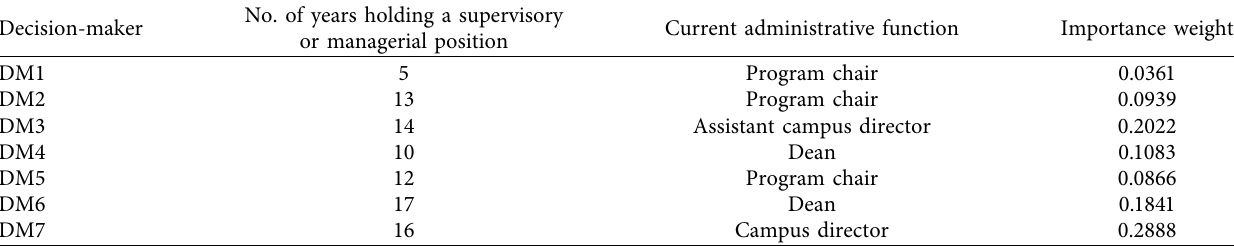
Table 4: Assignment of weights of